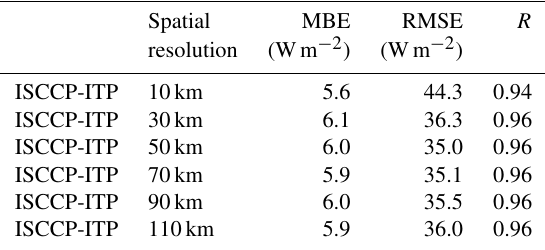
Table 1. Effect of spatial resolution (from 10 to 110km) on the accuracy of our estimated instantaneous PAR product (ISCCP-ITP) compared to observations at the seven SURFRAD